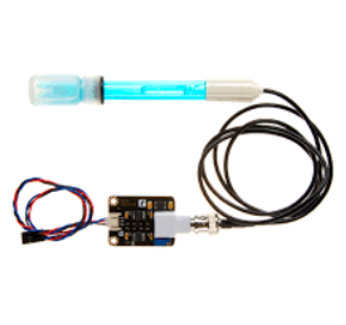
Fig. 8. NPK balance sheet